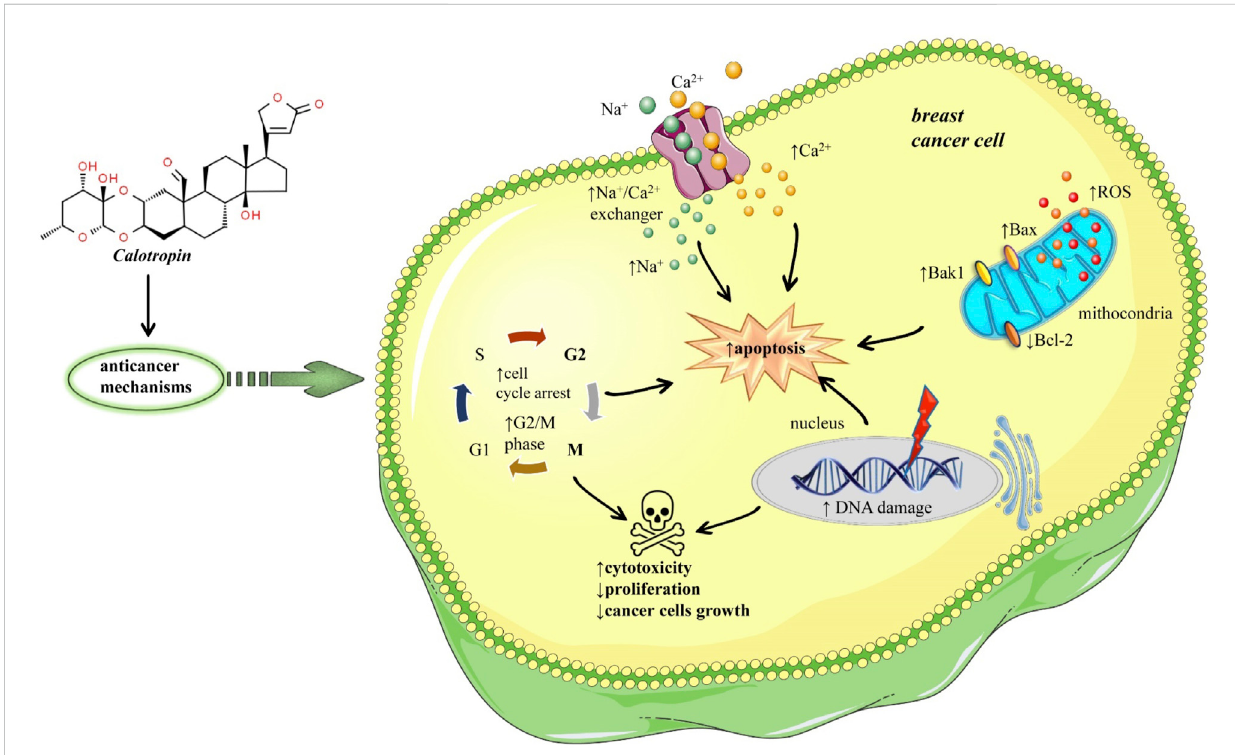
FIGURE 1 Potential mechanisms of anticancer effects of calotropin in breast malignant tumor. Calotropin inhibits Ca2+ ef fl ux via the Na+/Ca2+ exchanger, increasing intracellular Na+ and Ca2+, triggering apoptosis. Calotropin also induces apoptosis and cell death in tumour cells by disintegrating DNA and arrestingthecellcycleintheG2/Mphase.ItalsoincreasesBax/Bak1expressionandsigni fi cantlyreducesBcl-2expression,sothisBax/Bcl-2ratioplaysan important role in determining apoptosis. Symbols: ↑ increase, ↓